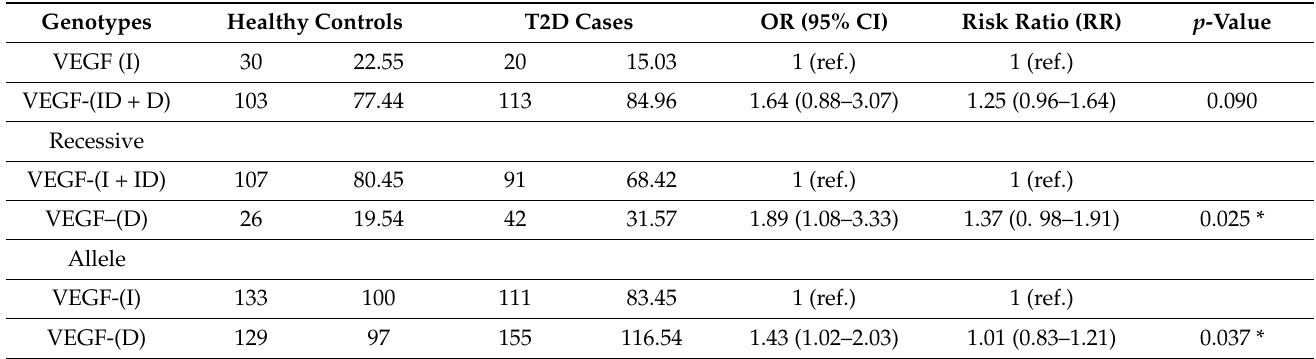
Table 9. Association of VEGF -2549 I/D genotypes with T2D patients’ characteristics.